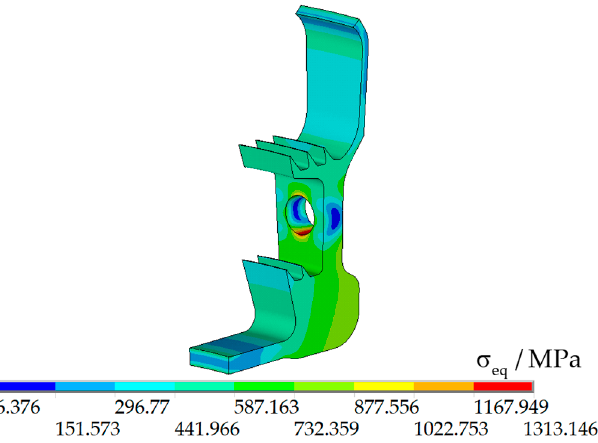
Figure 1. Von Mises stress distribution of the single-hole sector sub-model of the HPT sealing disk.